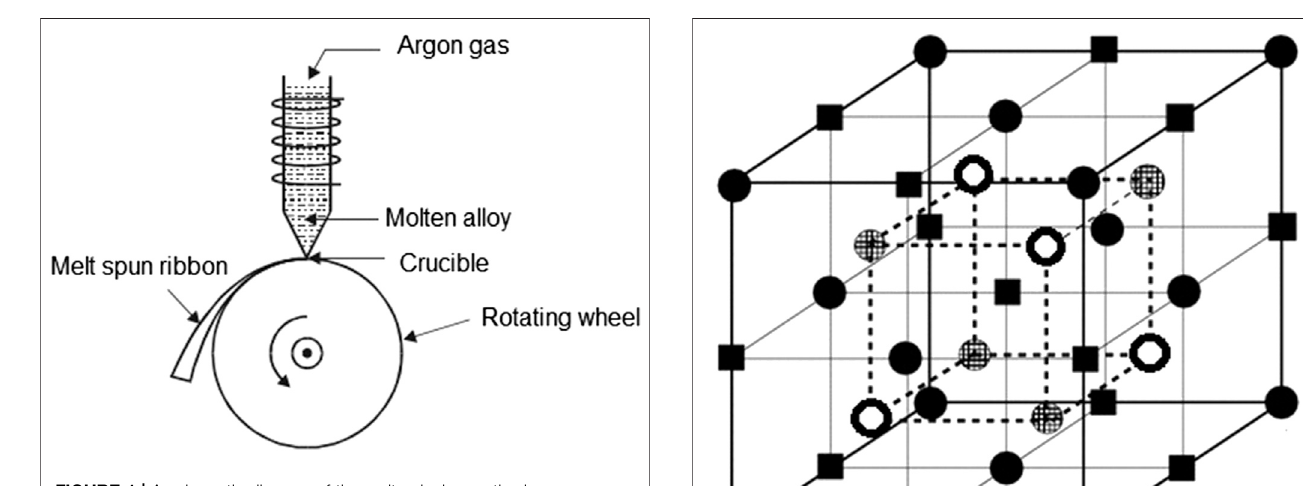
FIGURE 1 | A schematic diagram of the melt spinning method.